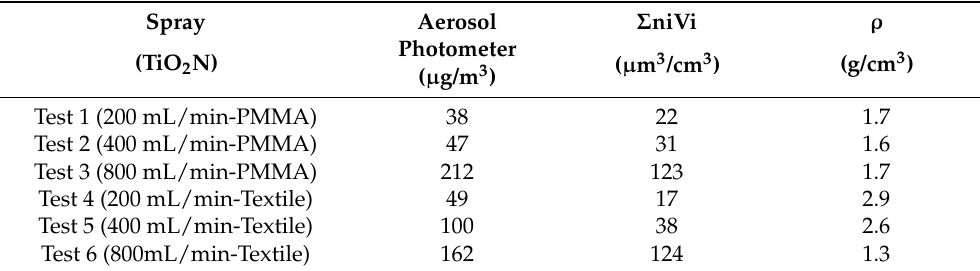
Table 2. TiO 2 N sprays. Aerosol mass concentrations were determined by aerosol photometer while total particle volume was obtained by the OPC. All data refer exclusively to spray spikes. The aerosol photometer data were corrected by the gravimetric correction factor.